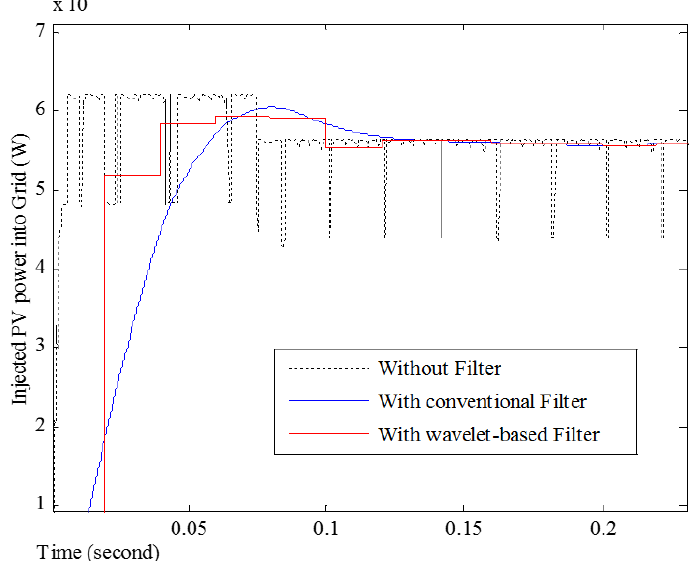
Figure 10. Extracted positive component of the injected PV power to the grid, using the wavelet-based low-pass filter and conventional low-pass filter. The sun irradiation decreases at 0.075 s from 1000 W/m 2 to 900 W/m 2 .